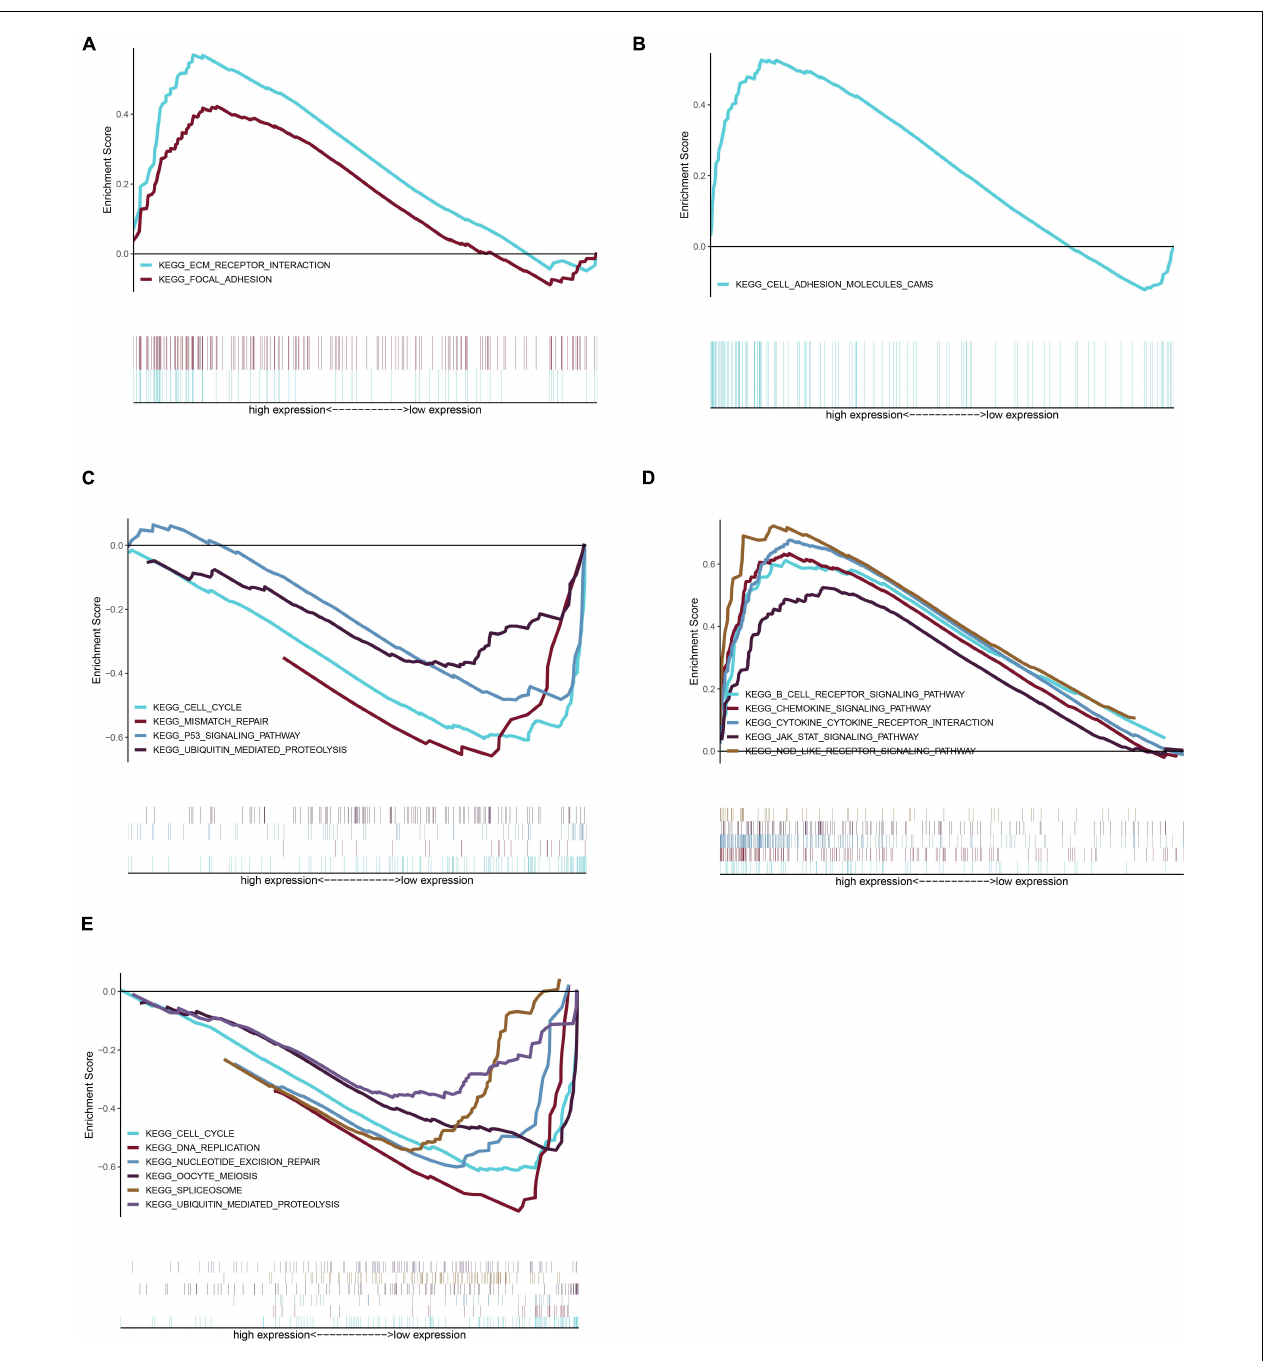
FIGURE 6 | Gene set enrichment analysis (GSEA) was performed for the three key genes based on the median expression profile. (A) The significant pathways were enriched in the high expression group of APLNR. (B,C) The significant pathways were enriched in the high and low expression group of CCL21, respectively. (D,E) In the FCGR2A, the significant pathway is shown in the high expression and low expression group, respectively.